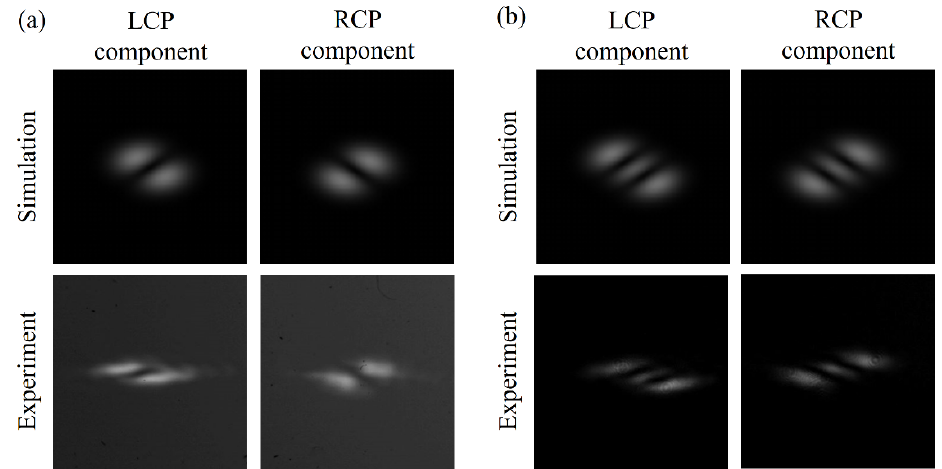
Figure 6. Numerically simulated and experimentally observed beam profiles at the two detection positions of the mode characterizer for an incident PV with ( a ) 𝑝 = 1 and ( b ) 𝑝 = 2 . Since the SPG and PPG is made of polymer liquid crystal, its birefringence and alignment pattern is almost immune to the temperature and vibration within the room temperature. As a result, the observed beam profiles in the experiment are stable for environmental